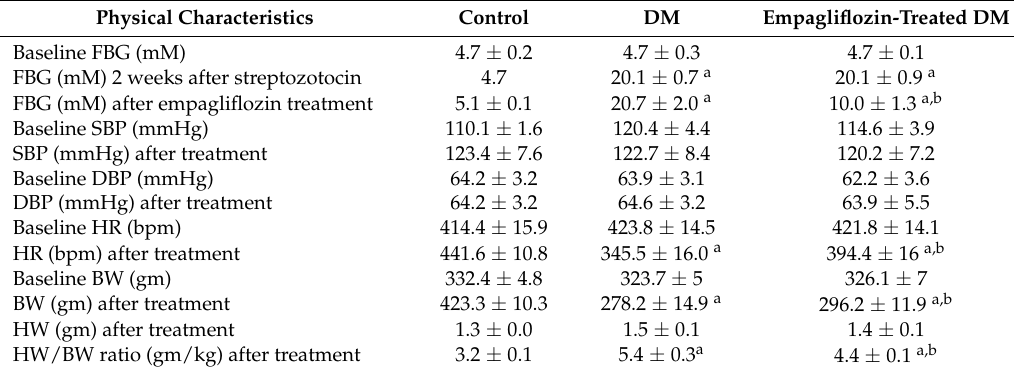
Table 1. Physical characteristics of the control, diabetes mellitus (DM), and empagliflozin-treated DM rats at 10 (baseline) and 16 weeks of age (after treatment).